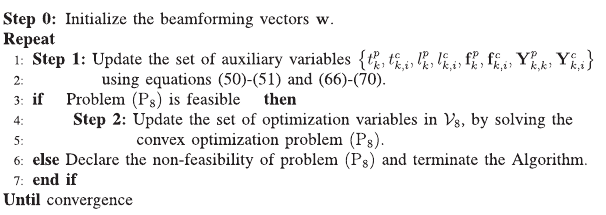
ALGORITHM 2 | Weighted sum-Power minimization subject to QoS